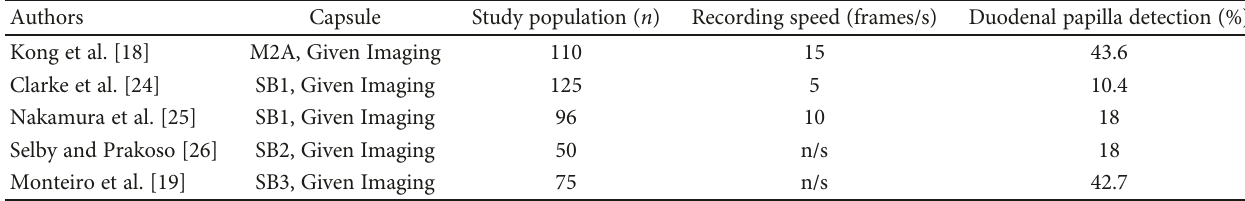
Table 3: Comparison of duodenal papilla detection rates.